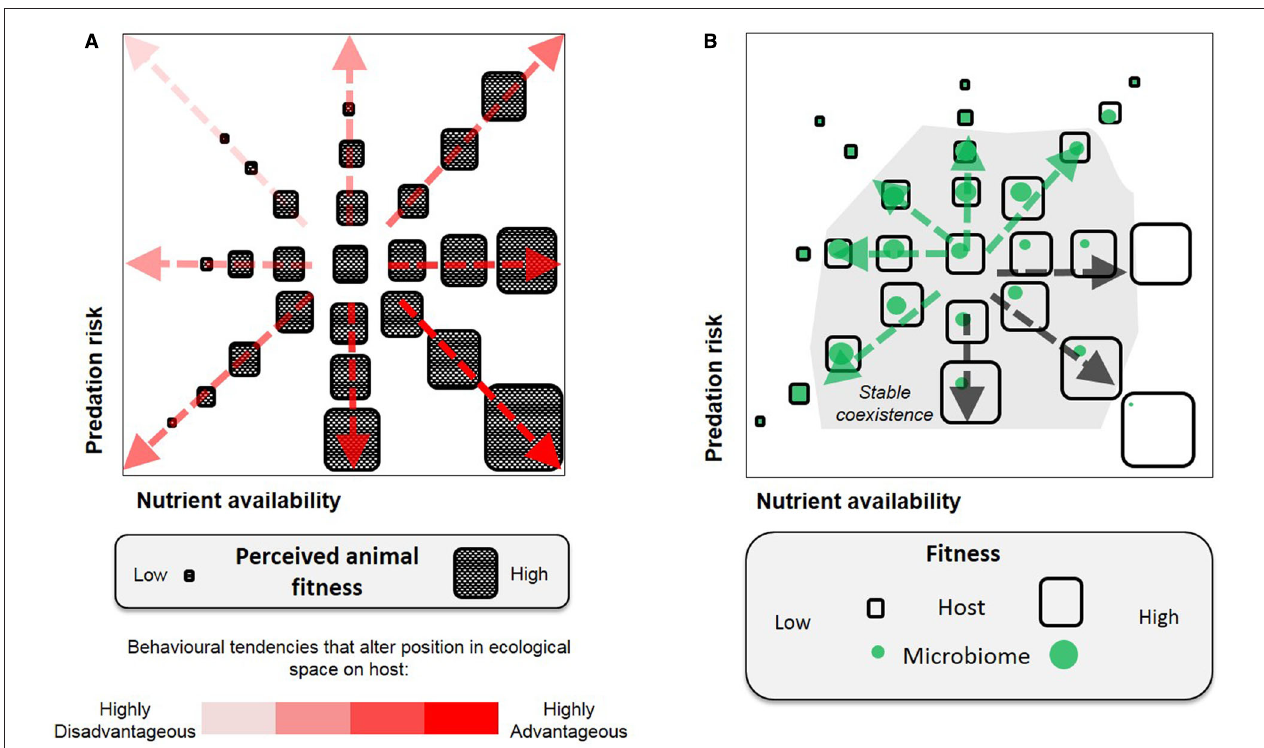
FIGURE 1 | Selection of animal behavior, illustrated by two dimensions of fitness parameters (nutrient availability and predation risk). (A) A host-centric view, only behavioral traits advantageous to animal fitness would be selected for. (B) A holobiont view, behavioral selection is bounded by host–microbe associations and involves positive and negative feedbacks between the host and microbes [relatively advantageous to microbes (green arrows) or the host (black arrows)]. The host–microbe relationship is not intrinsically parasitic or mutualistic, but is defined by the fitness outcome imposed by the environmental